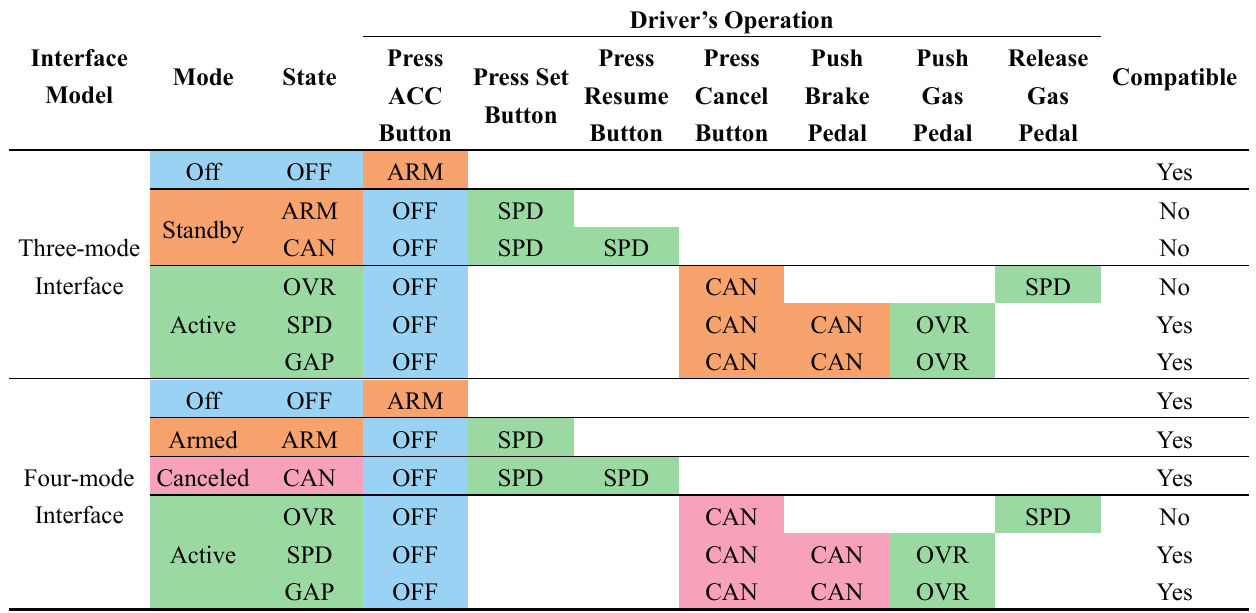
Table 3. State and mode transitions of the traditional ACC interface models.